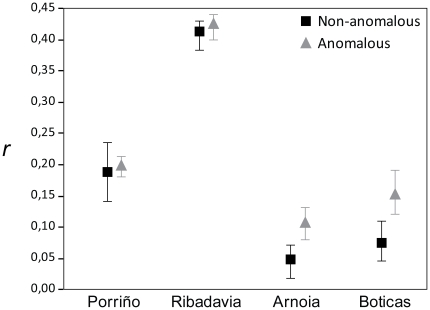
Mean relatedness for each population for anomalous and non-anomalous subsets (error bars determine the 95% confidence interval by bootstrap resampling).